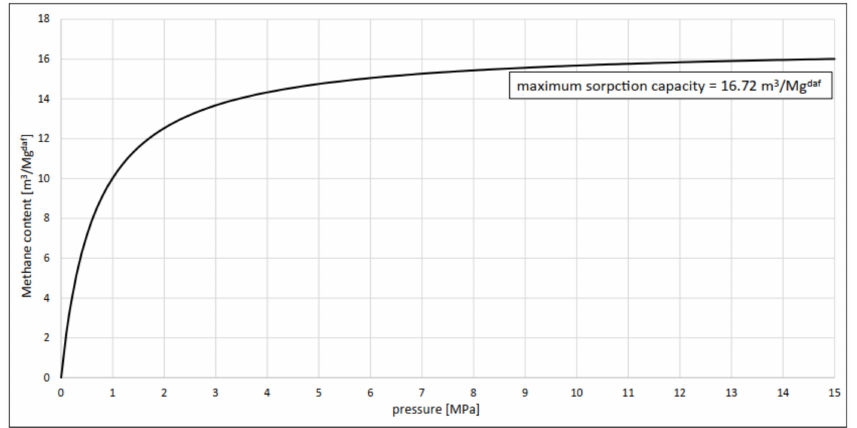
Figure 4. Langmuir sorption capacity of the coal from the Rydułtowy mine, taken from the depth of 1000 m.